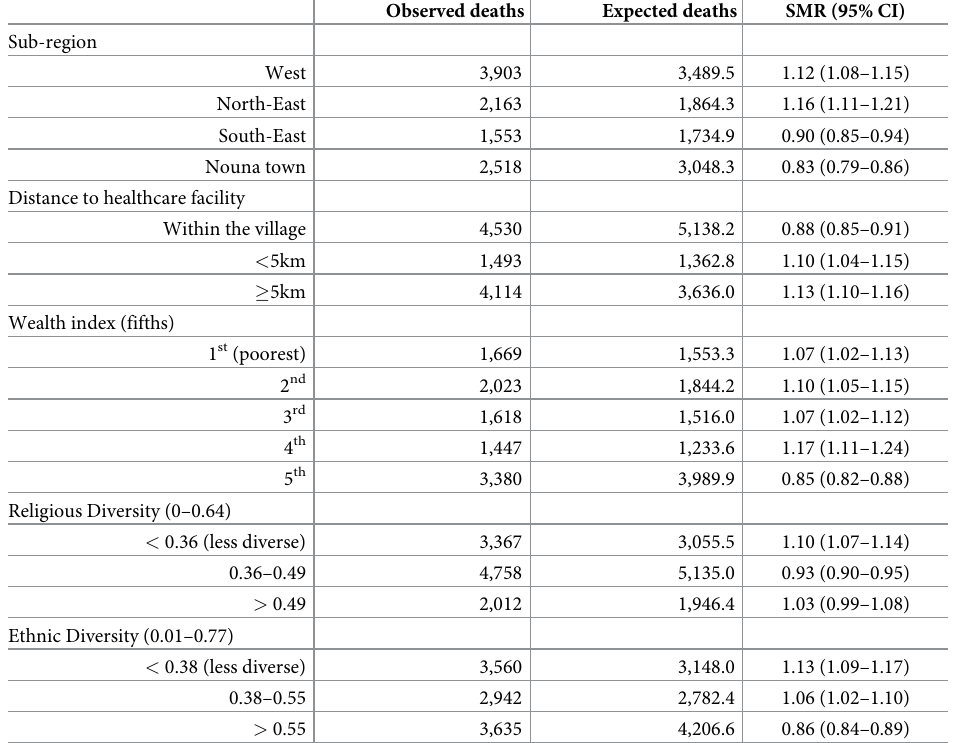
Table 2. Standardized mortality ratios for village characteristics in comparison to the entire Nouna Health and Demographic Surveillance